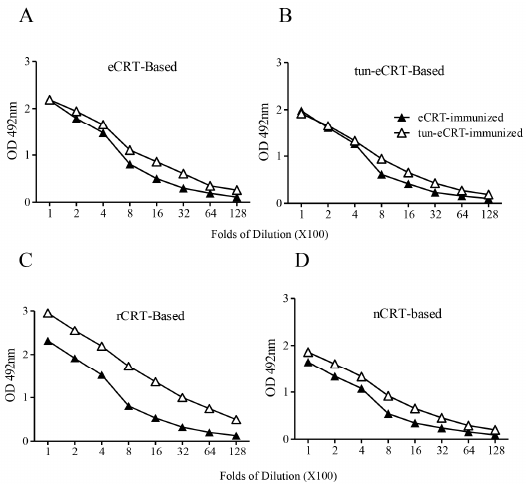
Figure 5. Comparison of immunogenicity of eCRT and tun-eCRT. Coomassie-blue stained SDS-PAGE gel slices containing eCRT or tun-eCRT were used immunogens for s.c. immunization of C57/BL6 mice ( n = 5). Immunized mice were boosted with the same antigens with fortnight intervals. Mice were bled 10 days thereafter for detection of antigen-specific IgG in ELISAs based on eCRT ( A ), tun-eCRT ( B ), rCRT ( C ) or nCRT ( D ). Results are expressed as mean ± SD of three replicates. These are representatives of 3 independent